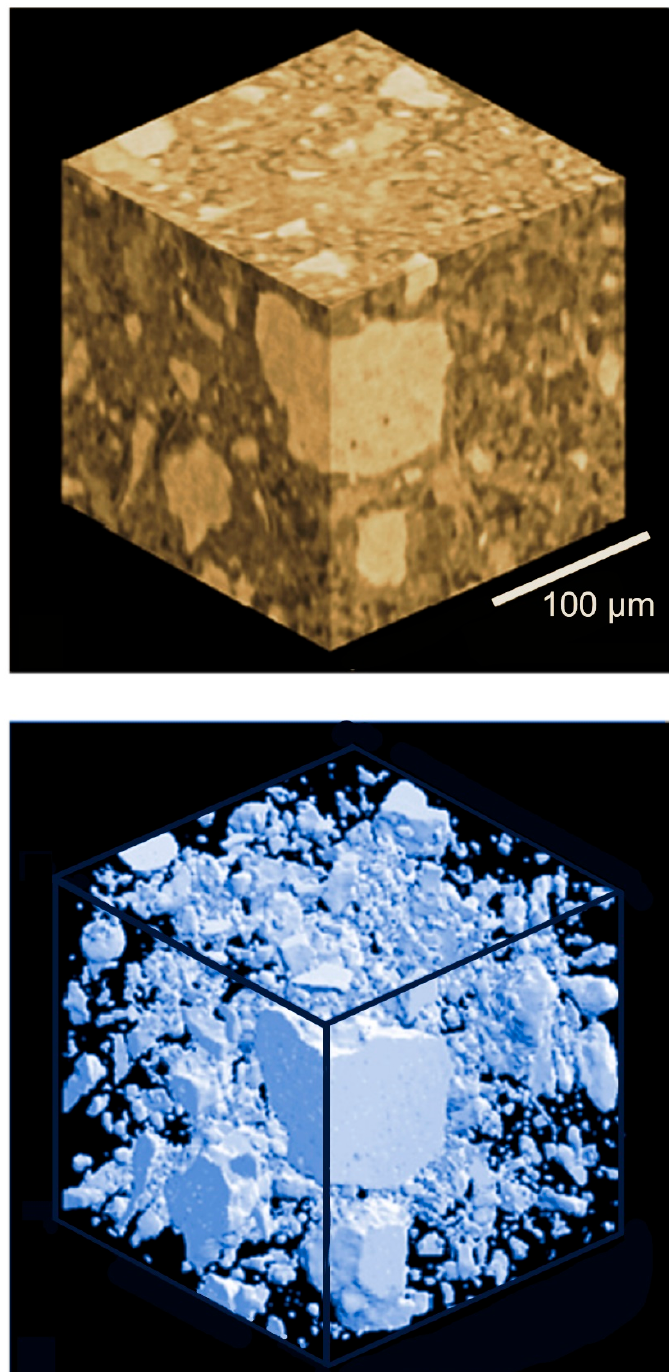
Figure 24. Example of coherence-based tomography: two reconstructions of a sample of concrete [39].